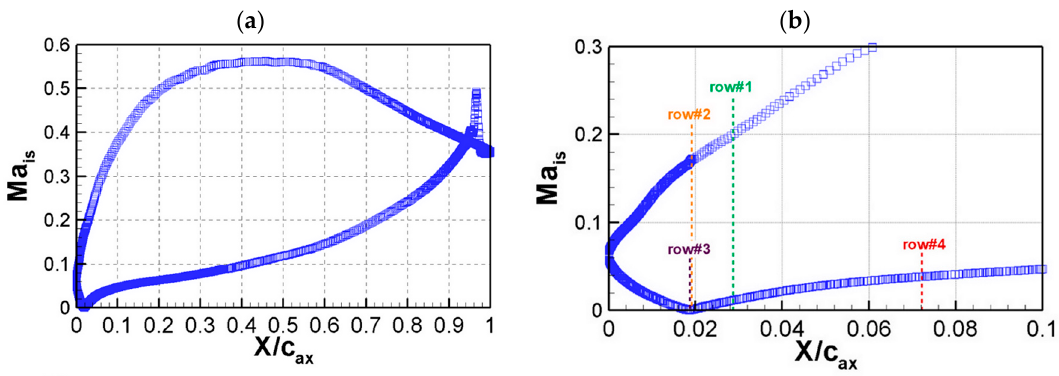
Figure 13. Isentropic Mach number ( Ma is ) distribution at midspan ( Z/H = 0.5) ( a ) with zoomed-in view on vane leading edge ( b ).